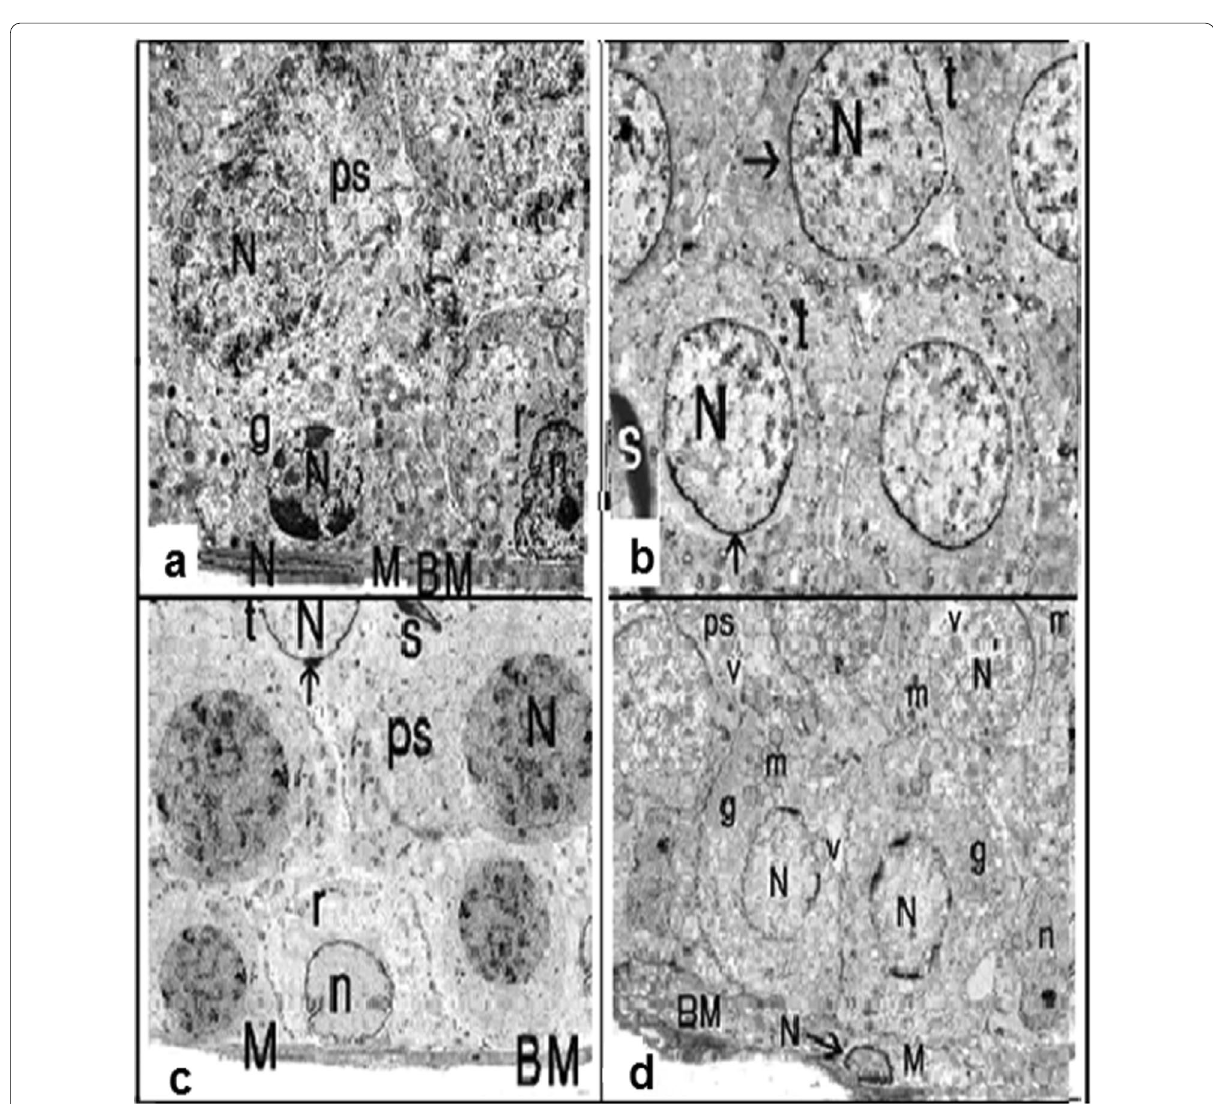
Fig. 3 a Transmission electron micrograph of sections testis of rats of a control group. showing: spermatogonia (g) with its small nucleus (N), primary spermatocyte cell (ps) with its large nucleus (N); Sertoli cell (r) with its dentate nucleus (n), rest on regular basement membrane (BM) with flat myoid cell (M) nucleus (N) (X 5000). b Transmission electron micrograph of sections testis of rats of a control group. showing: a group of spermatids (t) with a rounded nucleus (N) and acrosomal cap (arrow) and sperm (s) X15000. c Transmission electron micrograph of sections testis of rats of second groups. showing: spermatogonia (g) with its small nucleus (N), primary spermatocyte cell (ps) with its large nucleus (N), Sertoli cell (r) with its dentate nucleus (n), rest on regular basement membrane (BM) with flat myoid cell (M) nucleus (N), spermatids (t) with rounded nucleus (N) and acrosomal cap (arrow) and sperm (s) (X 5000). d Transmission electron micrographs of the third group rat testis showed irregular thick basement membrane (BM) with nuclear atrophy (n) of a myoid cell (M), vacuoles of cytoplasm (v) of degenerated spermatogonia (g) with its degenerated small nucleus (N), also damaged primary spermatocytes (ps), also vacuoles of cytoplasm (V), degenerated mitochondria (m), and endoplasmic reticulum. Also, damage of nuclear membrane (N), atrophy of Sertoli cell (r) with its atrophy nucleus (n) (X